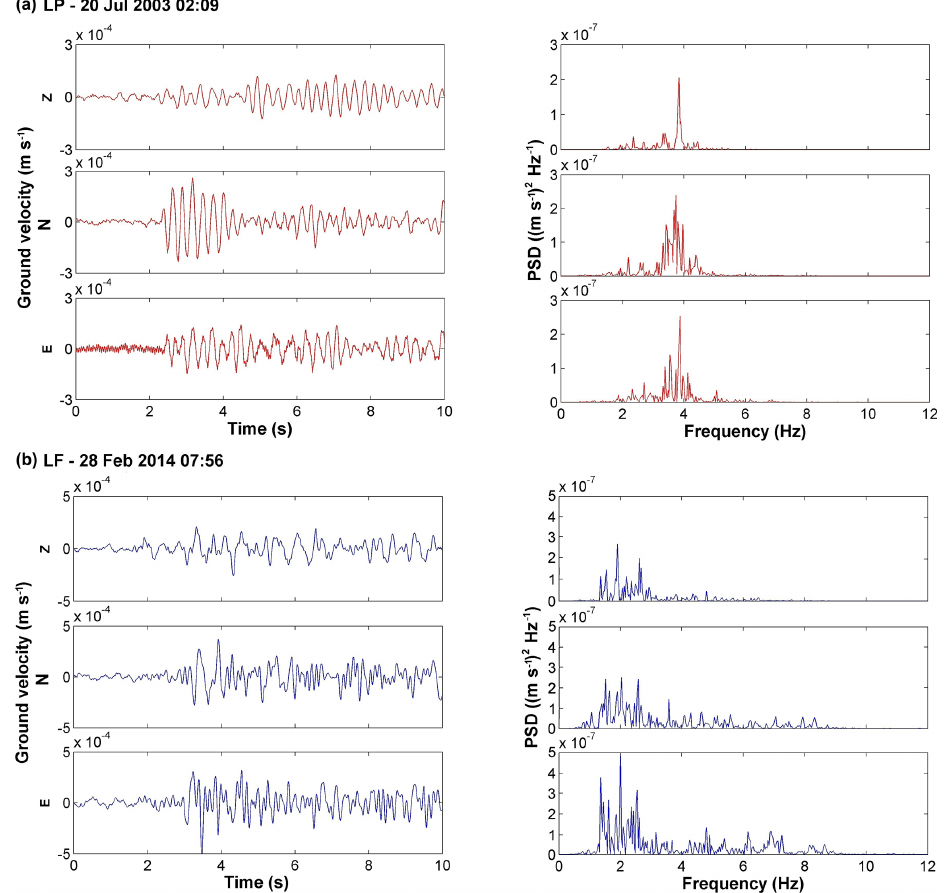
Figure 2. Examples of waveforms and spectra of the selected earthquakes. The three components of BKE (left) and the corresponding PSD (right) are reported, for LP03 in panel (a) (red) and for the LF earthquake occurred on 28 February 2014 in panel (b) (blue).